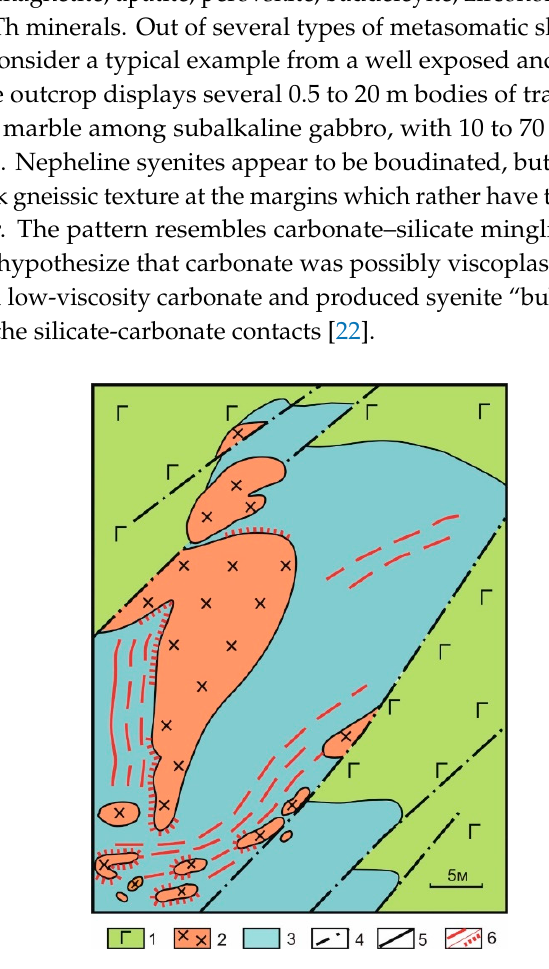
Table 1. Selected analyses of spinel and forsterite of the Tazheran Massif. Spinels